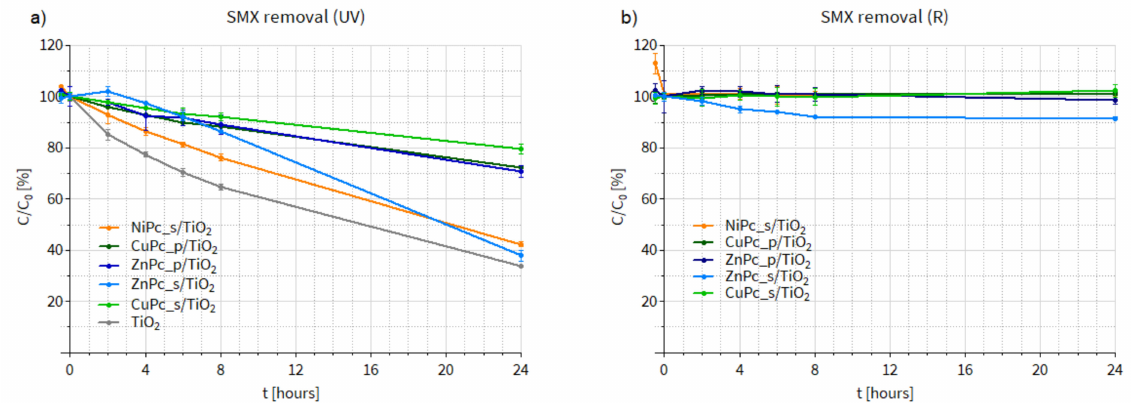
Figure 14. Changes in sulfamethoxazole concentration after ( a ) UV irradiation (365 nm light) ( b ) after R irradiation (665 nm light) of the water suspension containing a photocatalyst.